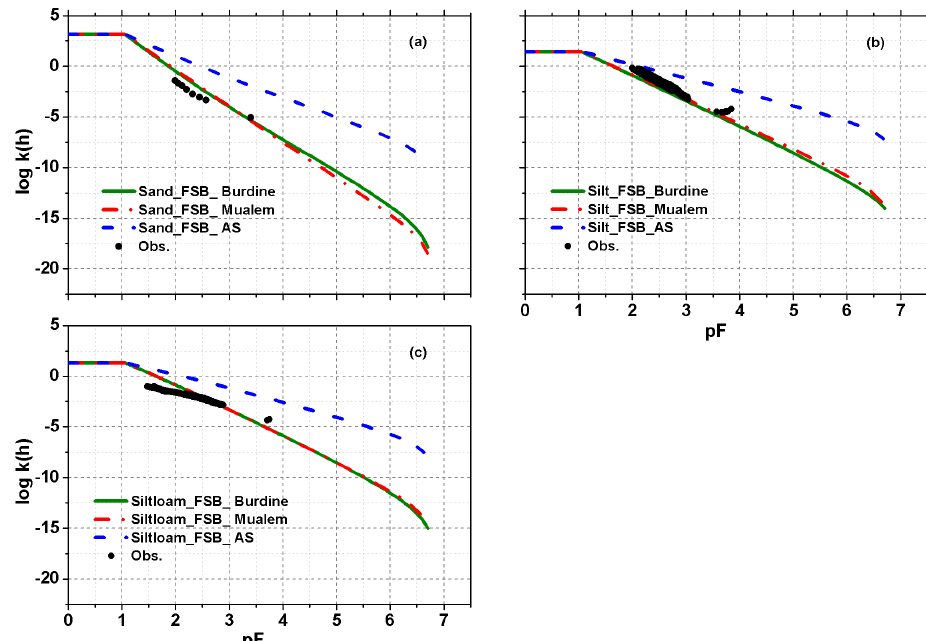
Figure 4. The observed and fitted hydraulic conductivity curve according to Burdine (1953), Mualem (1976), and Alexander and Skaggs (1986) using the fitted parameters of the Fayer and Simmons soil water retention curve (1995) for (a) sand, (b) silt, and (c) silt loam. The units of K are centimeters per day (cmd − 1